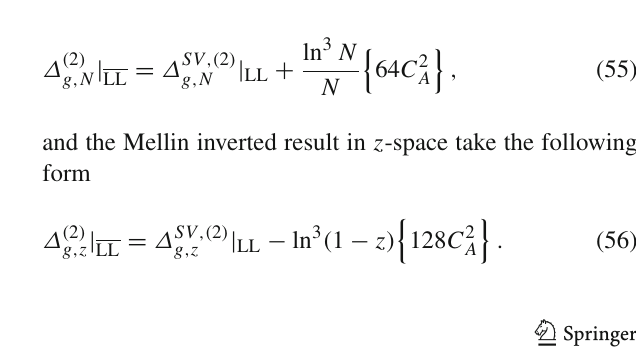
(cid:16) (cid:17) ˜ g g , g g (ω), g g (ω), h g (ω) which is required to predict the tower of NSV logarithms in Δ g , N at a given n n n 0 , n = ln j N / N N